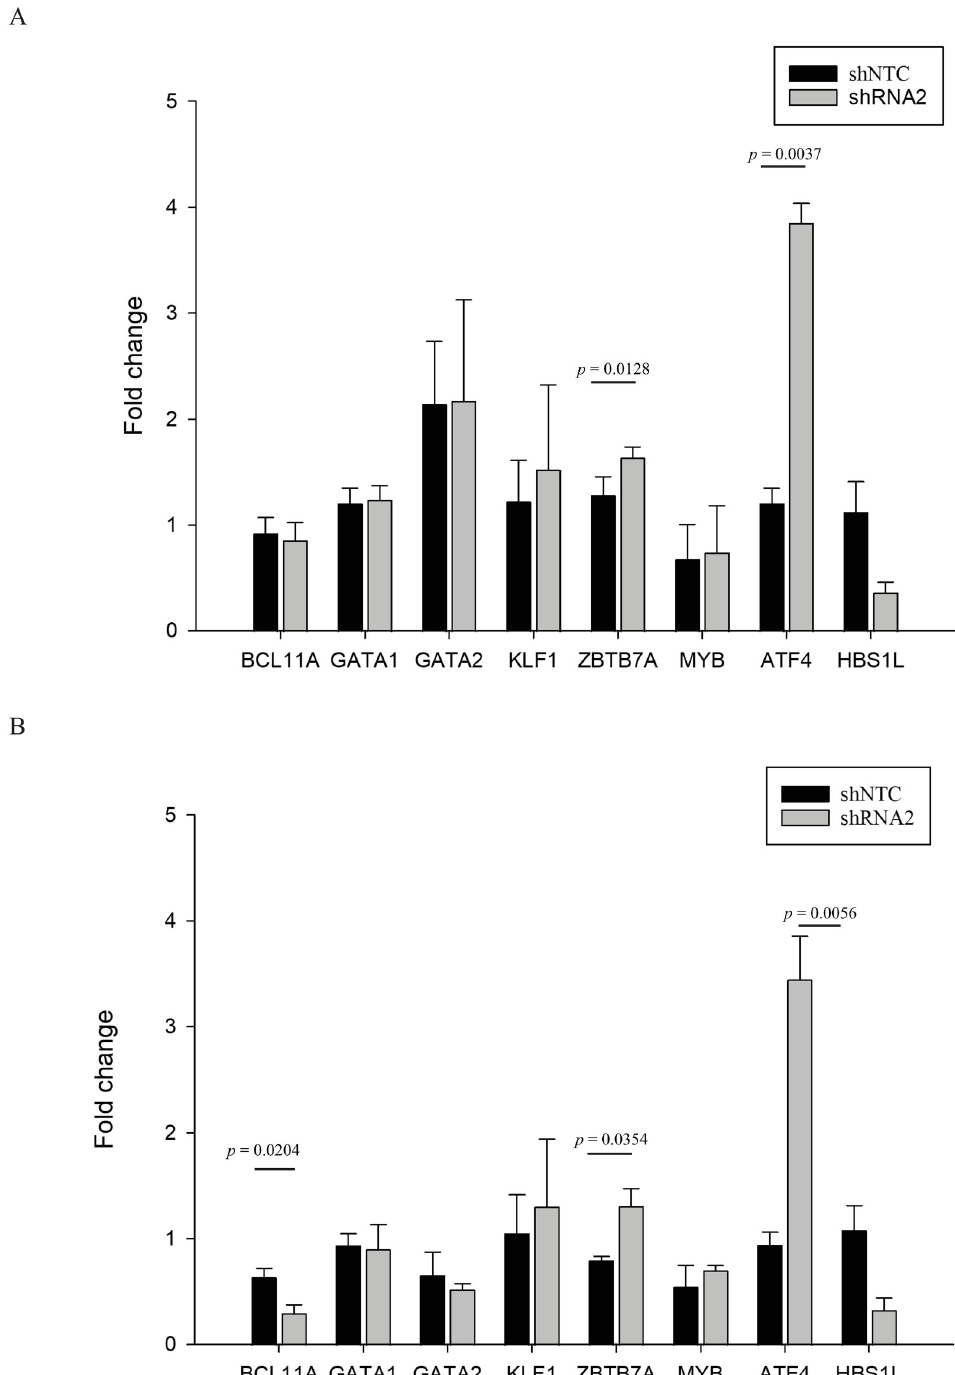
Fig 6. Effect of HBS1L knockdown on selected erythroid related transcription factors in healthy donors (A) and β 0 - thalassemia/HbE patients (B).